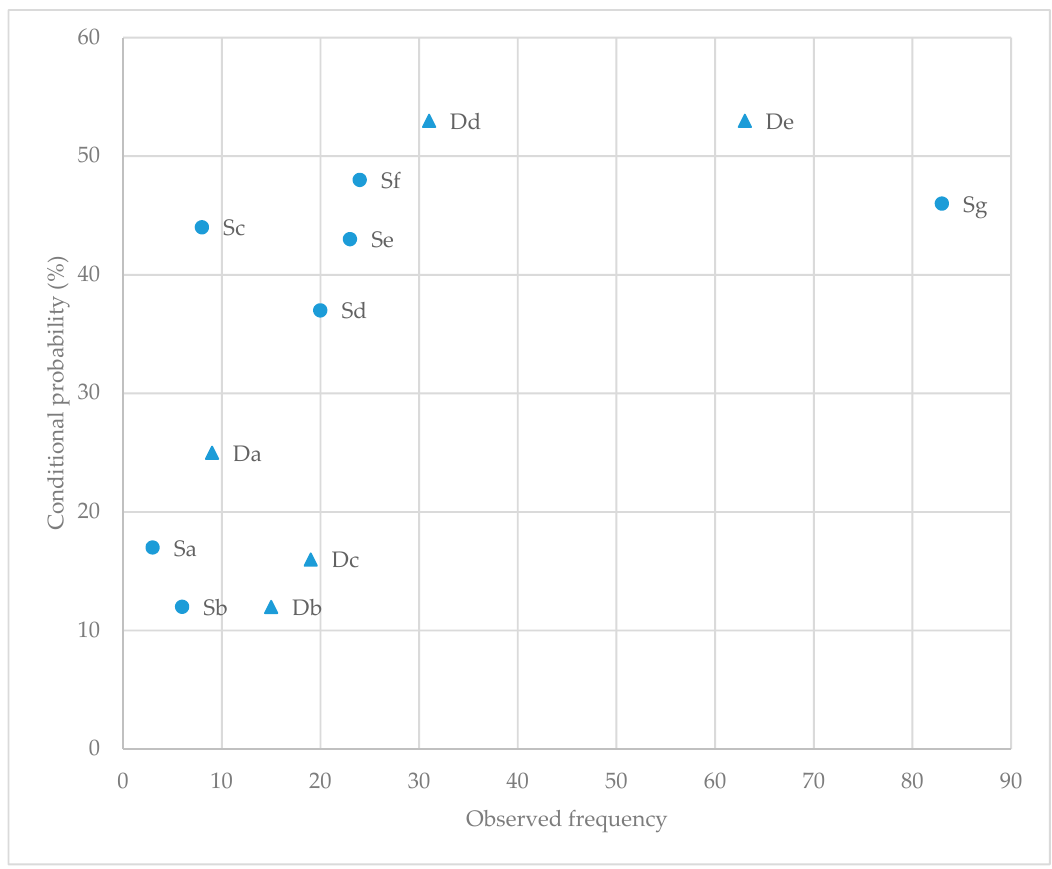
Figure 3. Significant event-based lag sequential analysis results (observed frequencies and conditional probabilities) for sheep behaviour response to dog behaviour and dog behaviour response to sheep behaviour. D—dog-initiated behavioural interactions (denoted by triangle); S—sheep-initiated